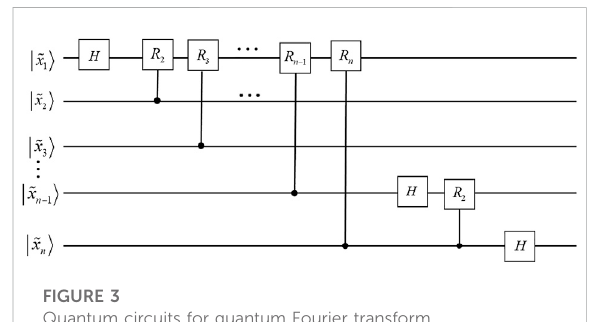
FIGURE 3 Quantum circuits for quantum Fourier transform.